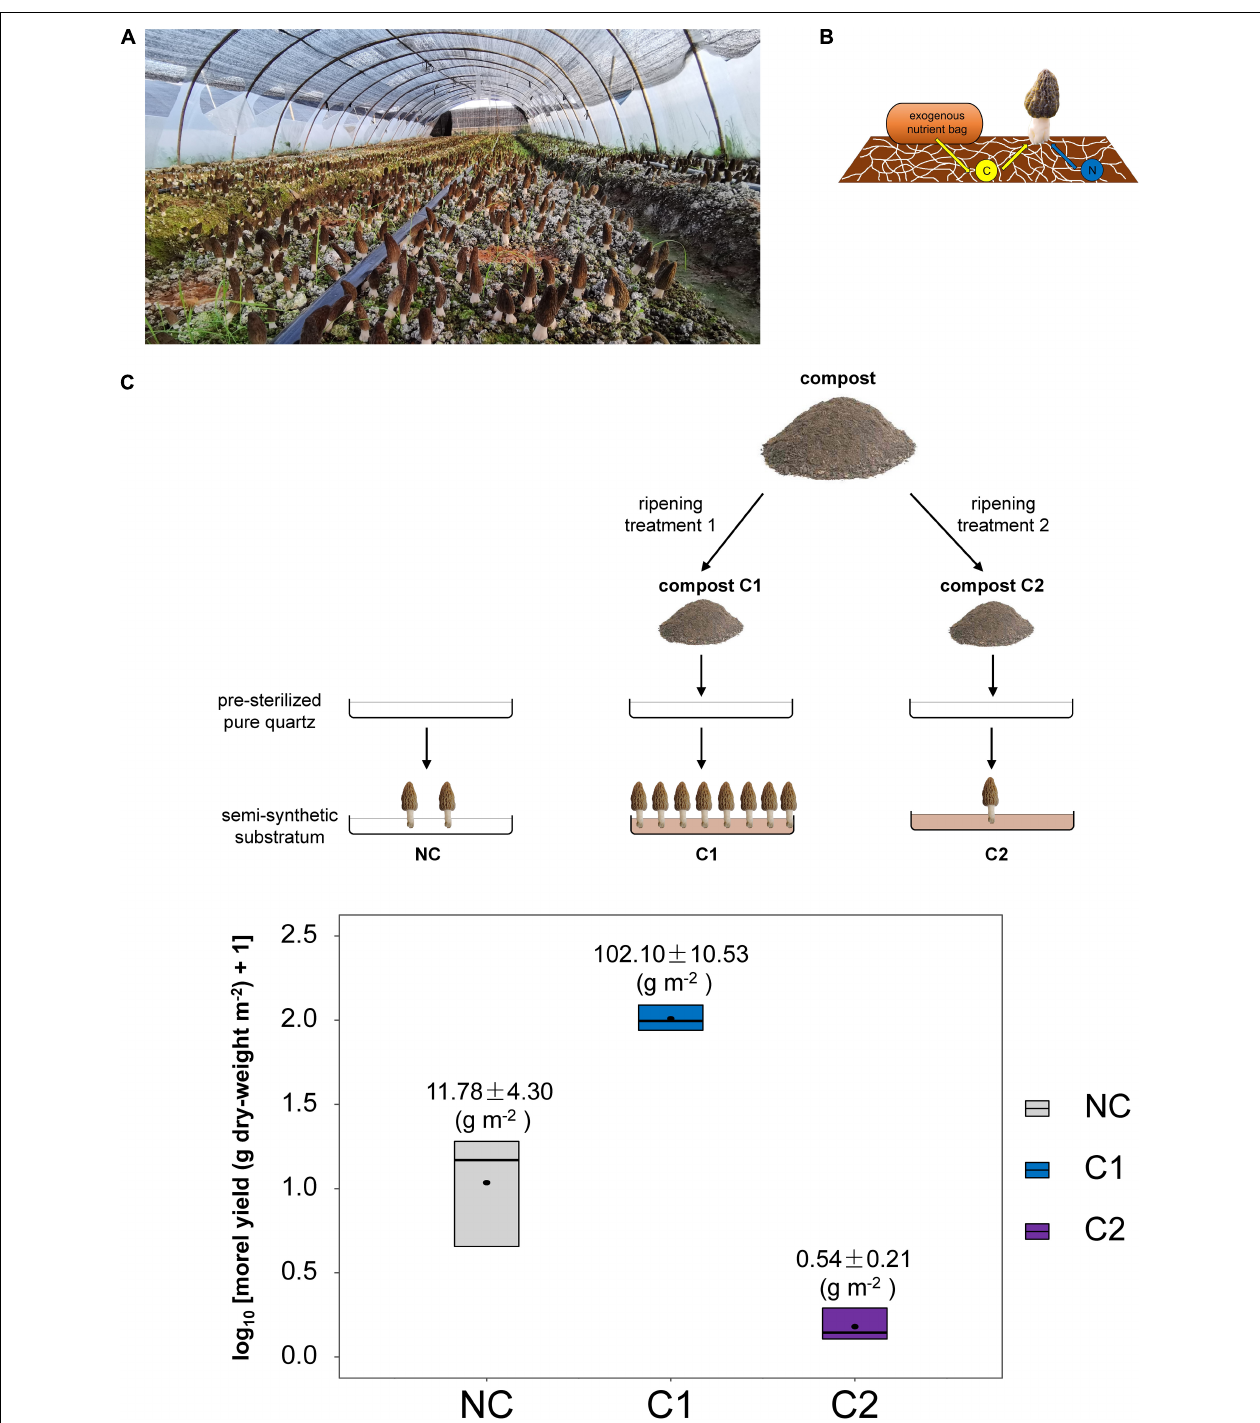
FIGURE 1 | (A) Soil substratum, the so-called mushroom-bed for the fructification of black morel in large-scale agricultural production. (B) The soil C source to support morel fructification was acquired initially from the aboveground nutritional supplementation of exogenous nutrient bags, while essential N nutrients were mostly from the soil itself, as reported previously (Tan et al., 2019). The exhausted exogenous nutrient bags could be either removed before fructification or left on the soil surface until the finish of fruiting-body harvest. The schematic diagram was modified from the cover-illustration of issue 10, volume 21 of Environmental Microbiology (2019). (C) Schematic diagram of the experimental design in this study and the morel yield obtained from the three types of semi-synthetic